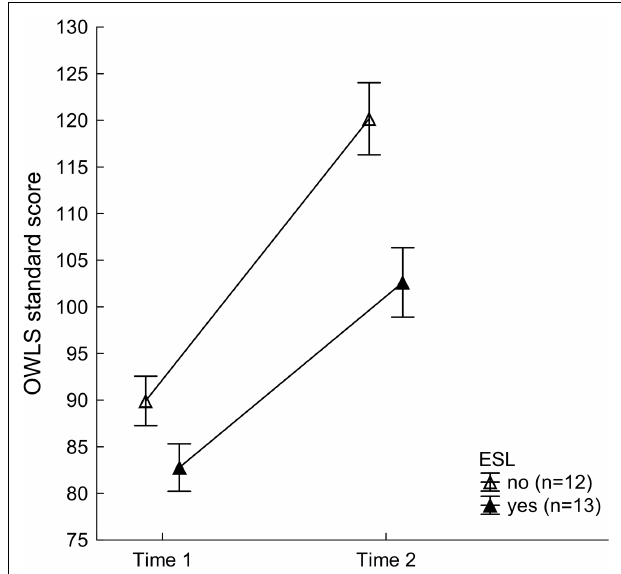
FIGURE 4 |Written Expression Scale standard scores of the Oral and Written Language Scales (OWLS) for the training group as a